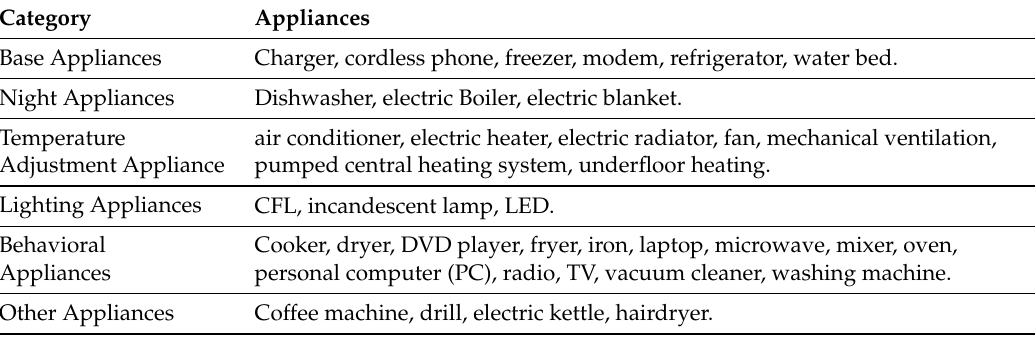
Table A1. The list of